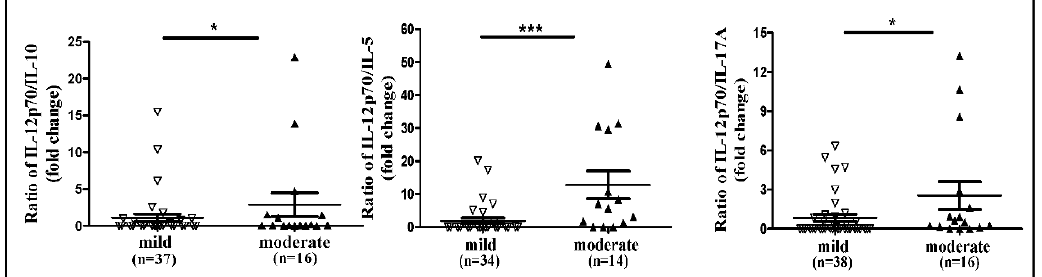
Figure 2. Ratio of Th1 to Th2 cells and Th1 to Th17 associated with severe CDI. * p < 0.05, ** p < 0.01, *** p < 0.001.